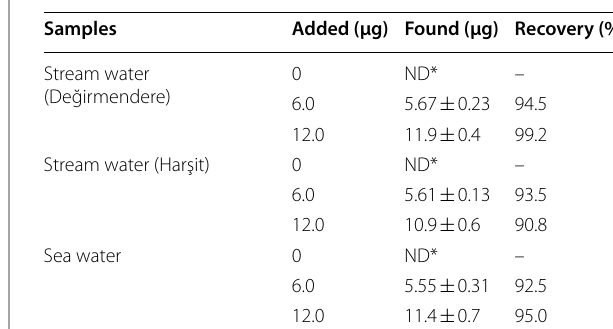
Fig. 6 Comparison of ANN output and experimental data